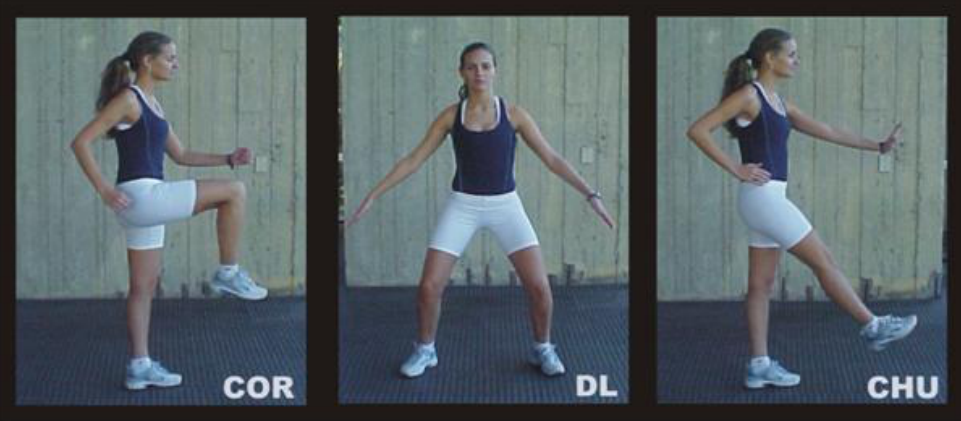
Figura1. Exercícios realizados: (COR) Corrida estacionária. (DL) Deslize lateral. (CHU) Chute frontal a